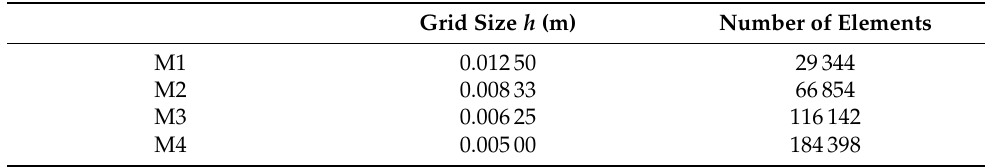
Table 3. Mesh data for 2D rising bubble mesh sensitivity study.